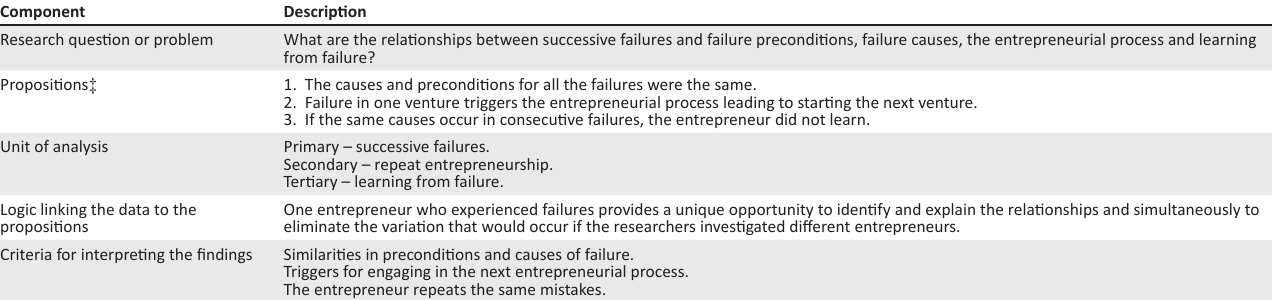
TABLE 1: Research design components based on the design description of Yin † .